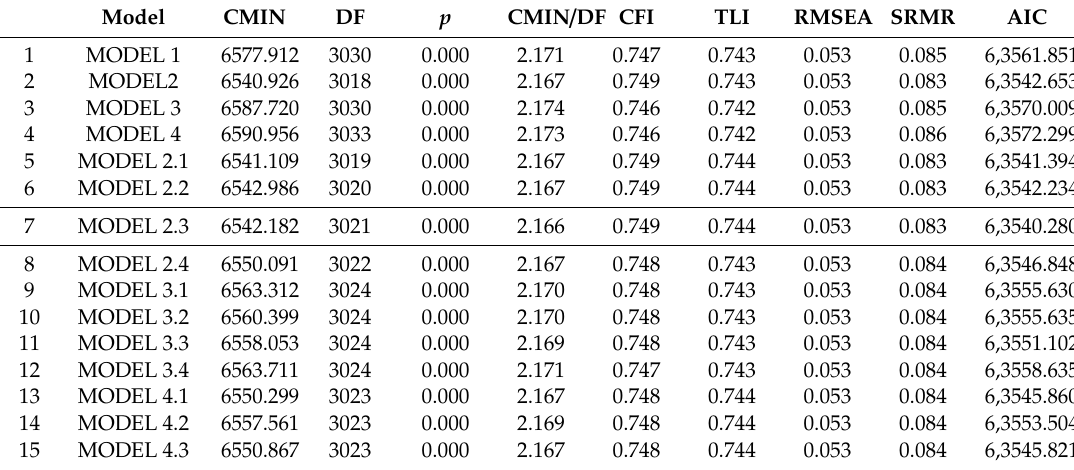
Table 2. Fit indexes for structural equation